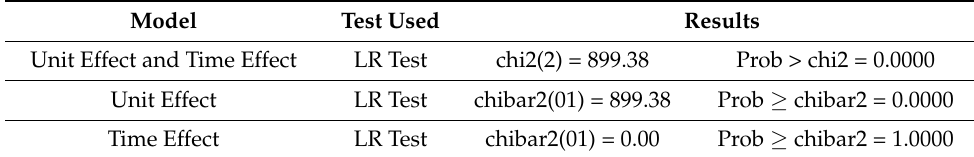
Table 5. Unit and time effects LR test.